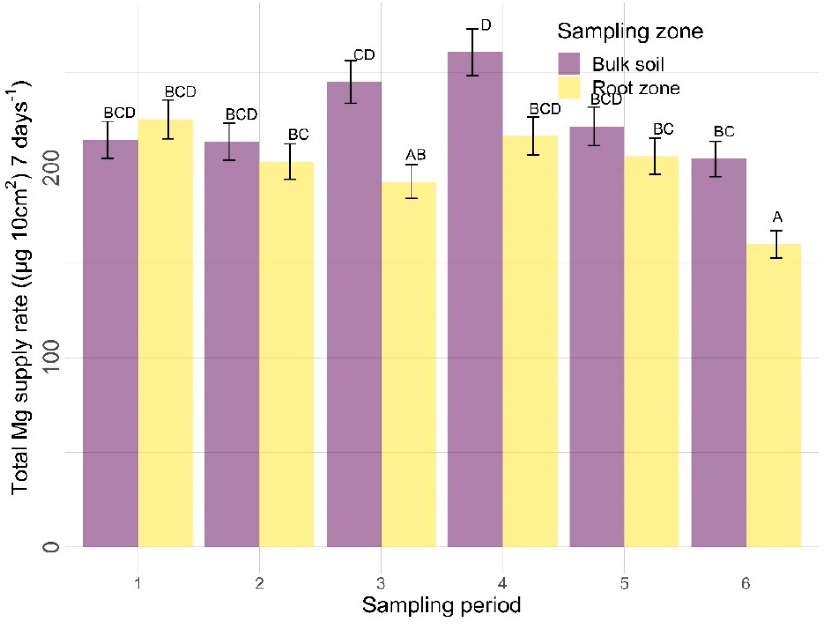
Figure 10. Mg supply rates as a function of sampling zone and time. Different letters indicate significance at p < 0.05 using the post hoc Tukey HSD test.